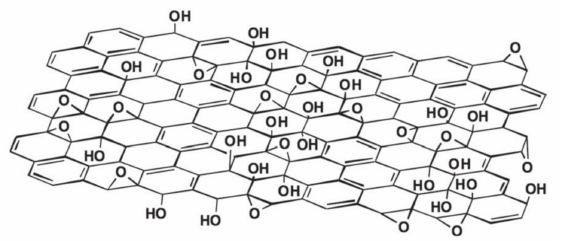
Figure 1. A schematic of graphene oxide structure (Reproduced with permission from ref. [35]. Copyright 2010 Wiley Publications).